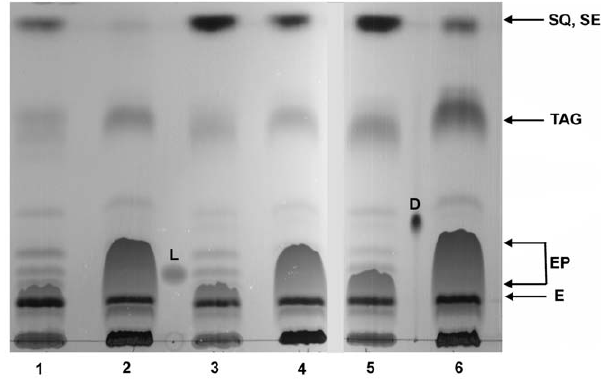
Figure 1. TLC analysis of simple lipids. A significant drop in the level of sterol precursors in cells cultivated in the presence of simvastatin indicates that the ergosterol intermediates were efficiently converted to ergosterol. The decrease of the steryl esters is also clearly visible after statin treatment. Lanes 1, 3, 5 lipids from cells harbouring the wild-type yeast, or the wild-type or mutated hHMGR gene, respectively. Lanes 2, 4, 6 lipids from cells treated with simvastatin harbouring the wild-type yeast, or the wild-type or mutated hHMGR gene, respectively. Abbreviations: SQ squalene, SE steryl esters, TAG triacylglycerols, EP ergosterol precursors, E ergosterol, L lanosterol, D dolichol composed of 16 isoprene residues.